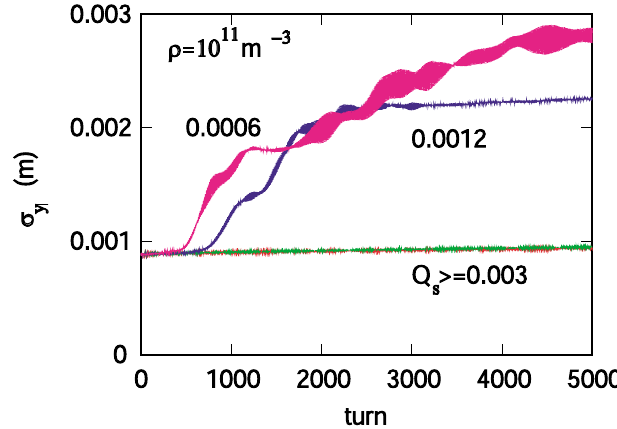
FIG. 37. (Color) Schematic of the simulation algorithm in the code HEADTAIL modeling the single-bunch instability due to an electron cloud [105].